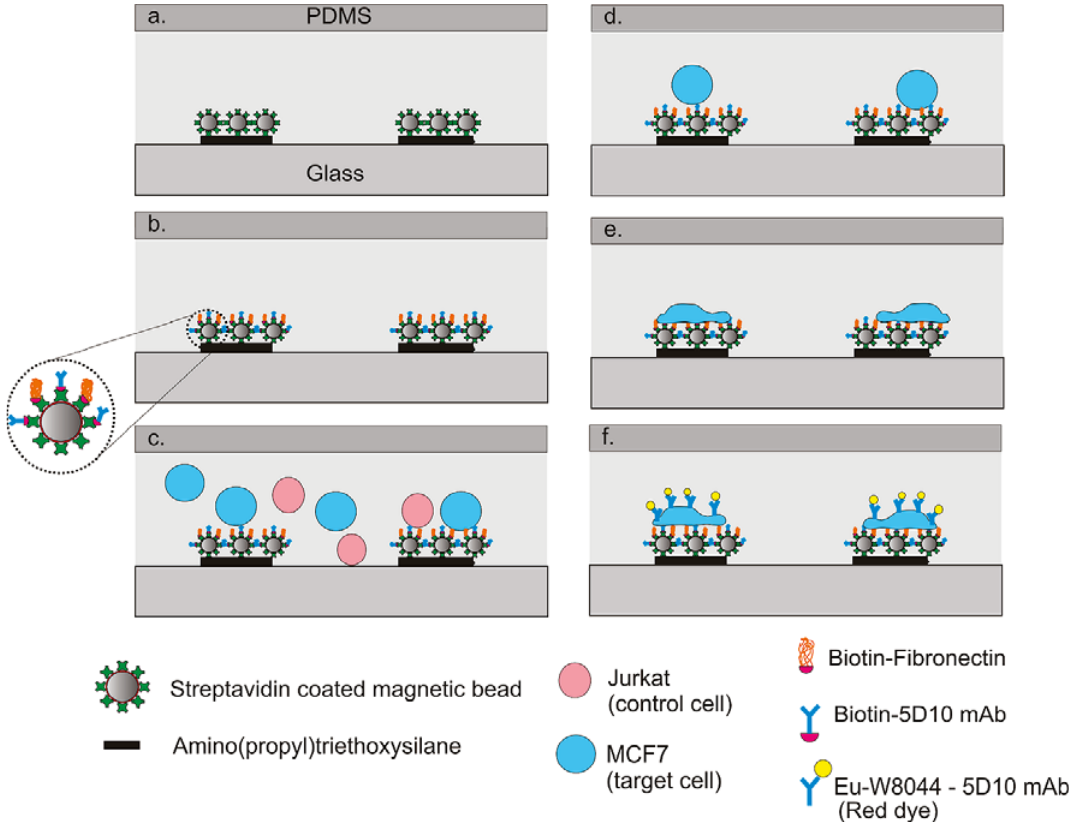
Figure 6. Schematic illustration showing the concept of specific capture from a cell mixture of MCF-7 cells on self-assembled beads micropatterned in situ inside a microfluidic channel, followed by subsequent culturing. (Reprinted with permission from [26]. Copyright 2010 American Chemical